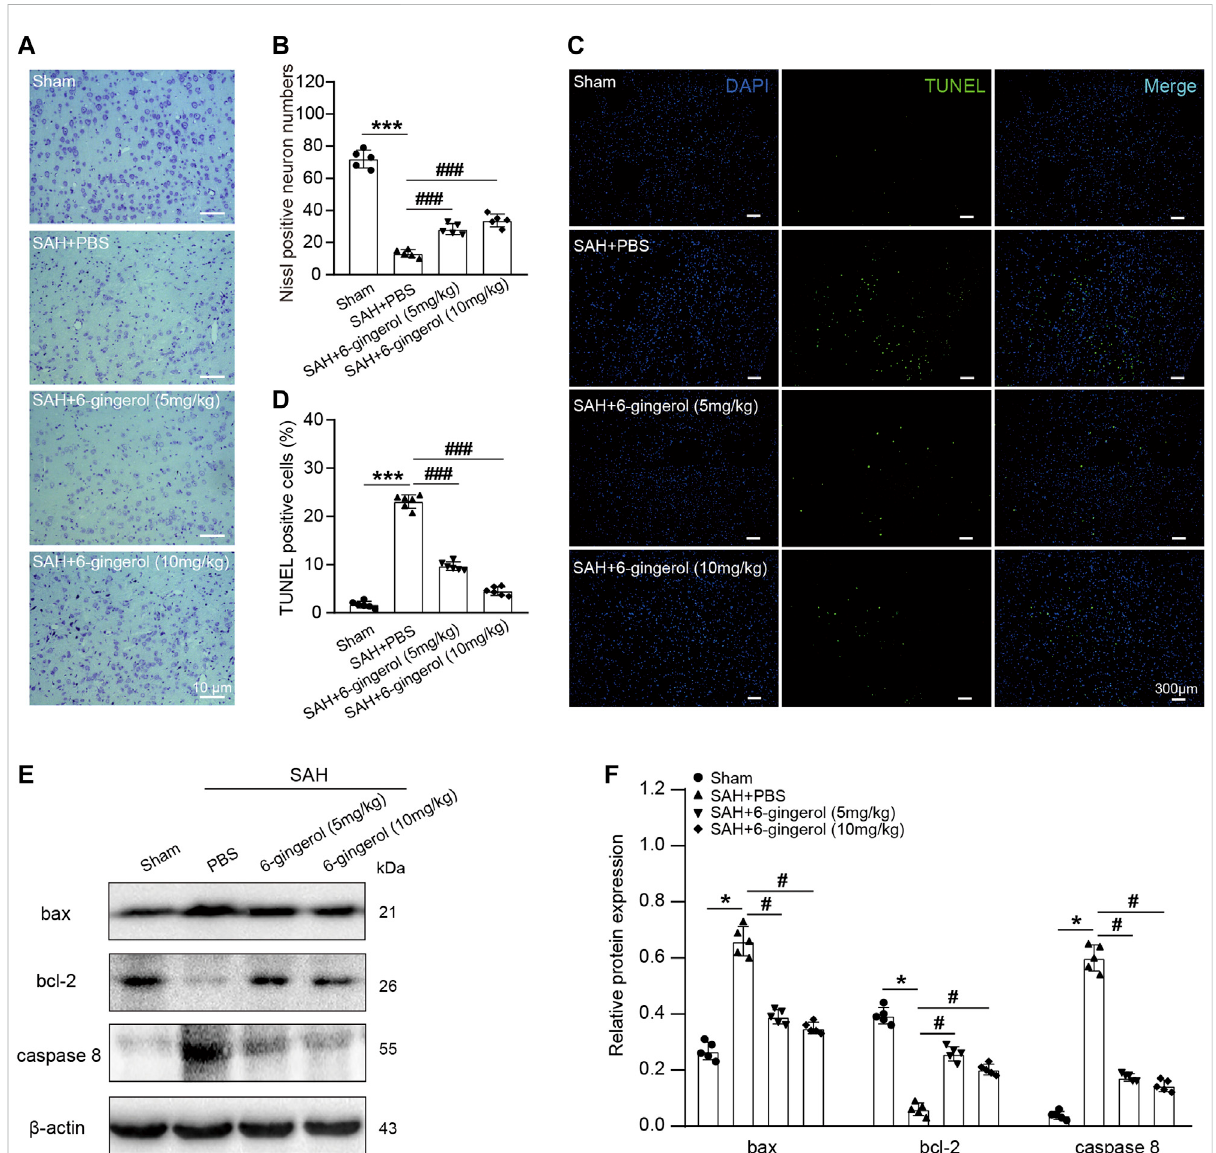
FIGURE 2 6-gingerol alleviates neuronal apoptosis in SAH rats. (A) Representative images of Nissl staining. Scale bar = 10 μ m. (B) Quantitative analysis of Nissl-positive neuron numbers, n = 5. One-way ANOVA was used followed by Tukey ’ s post hoc test. (C) Representative images of TUNEL staining. Scale bar = 300 μ m. (D) Quantitative analysis of TUNEL-positive cells, n = 6. One-way ANOVA was used followed by Tukey ’ s post hoc test. (E) Bax, bcl-2andcaspase8proteinexpressionweredetectedbywesternblot,n=5. (F)